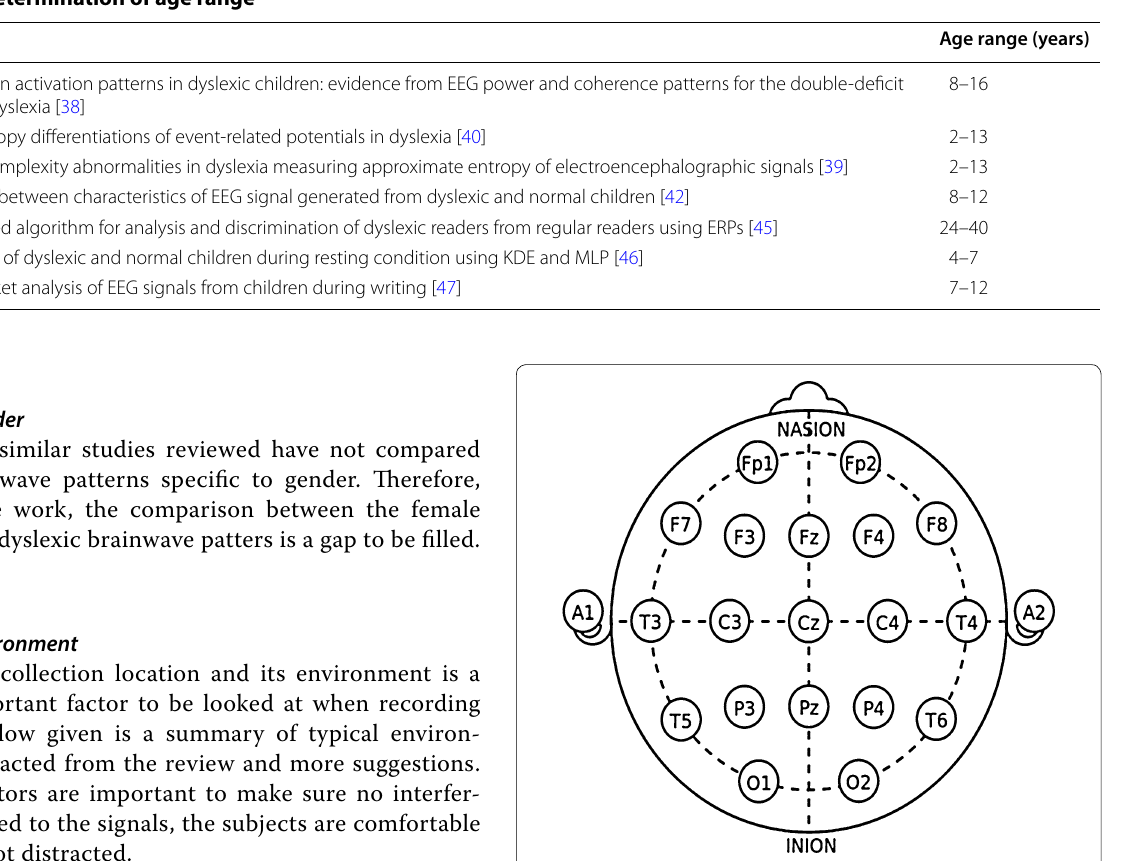
Fig. 4 Arrangement of the international 10–20-electrode system